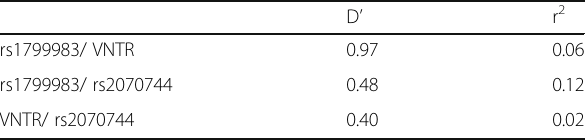
Table 5 Pairwise linkage disequilibrium between the